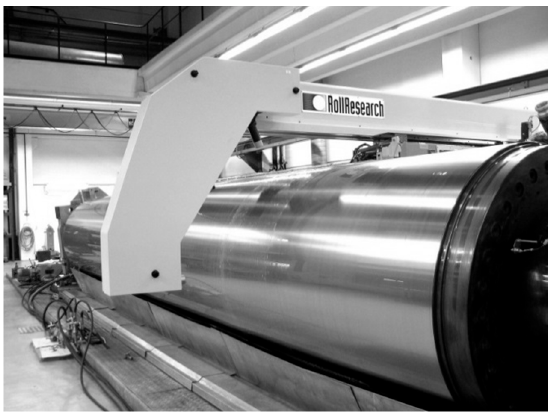
Figure 4. Roll measuring device for measuring the roundness and shape of a roll.